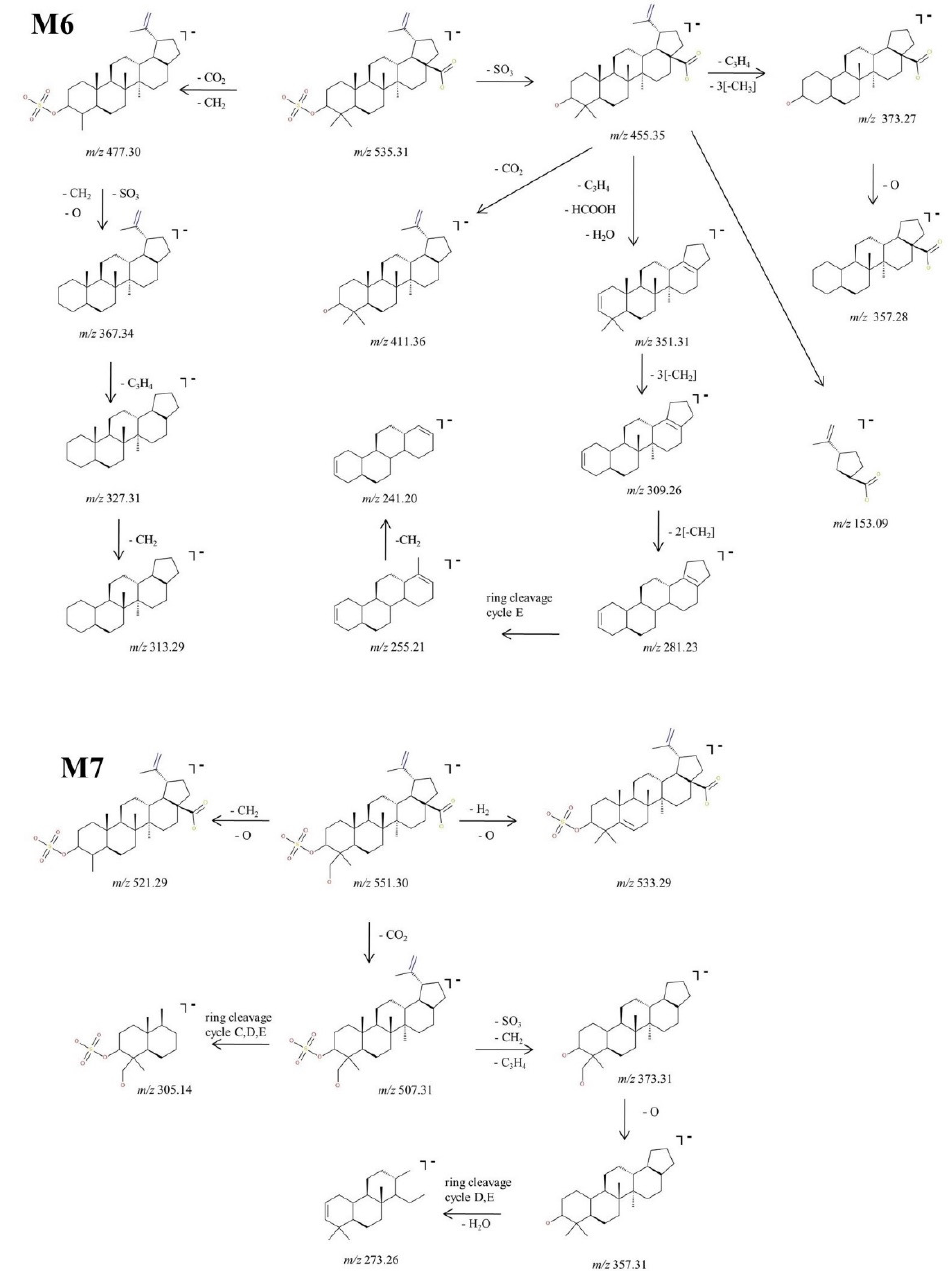
Figure 7. Proposed fragmentation pathway for phase II metabolites: M6–M7.